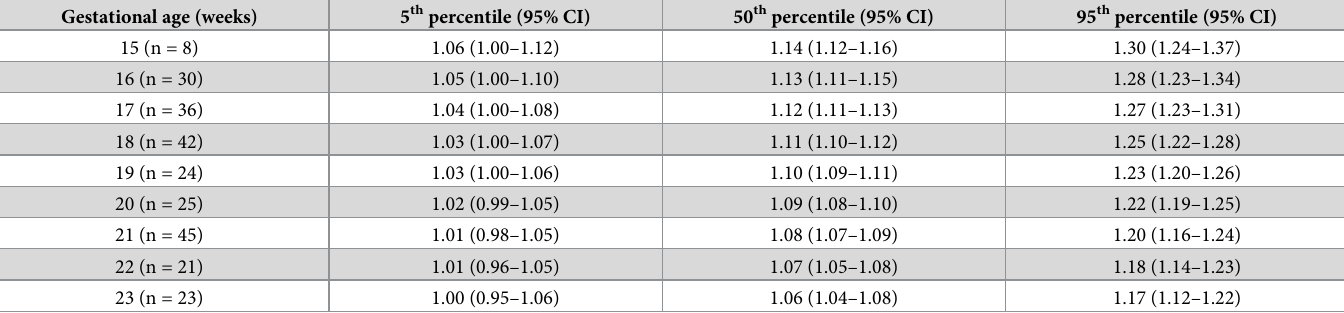
Table 4. Reference range of mandible width/maxilla width ratio (MD/MX ratio) as estimated by back transformed from quantile regression analysis of ln(MD/MX ratio) with 95% confidence interval along gestational age (N = 254). Gestational age